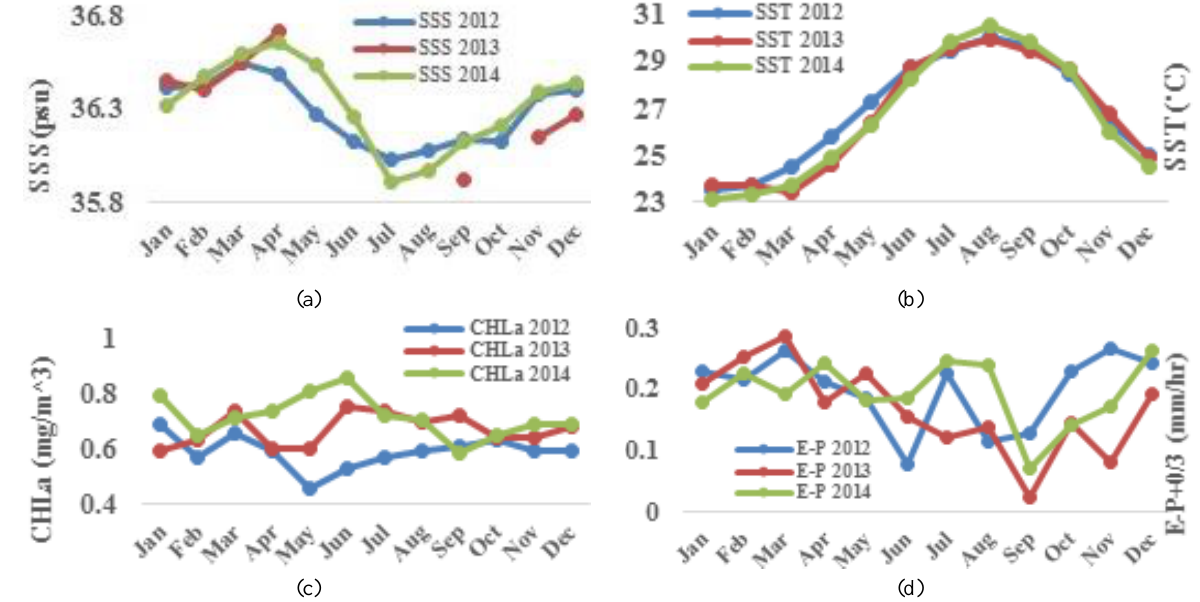
Figure 4. Monthly average variations of (a) SSS, (b) SST, (c) CHLa, and (d) E-P for 2012 to 2014 in the Gulf of Mexico